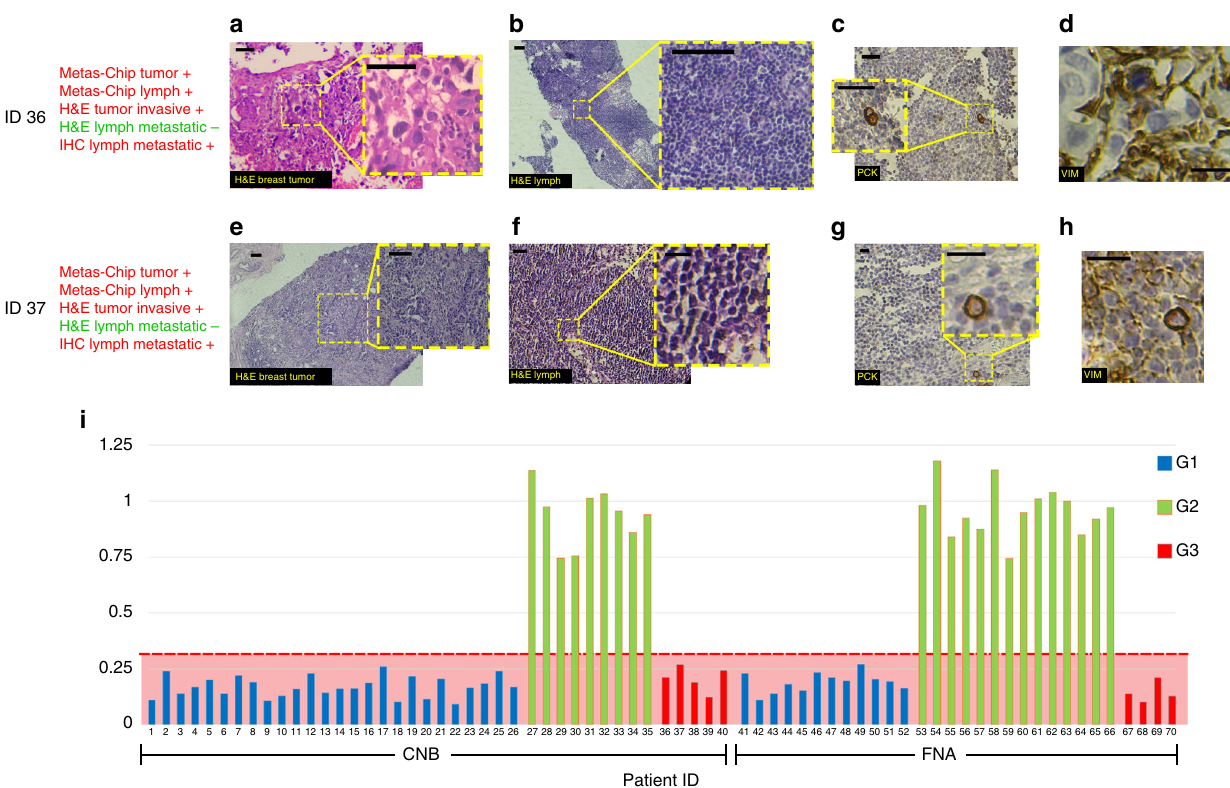
Fig. 4 H&E stained from breast specimen of patients present invasive ductal carcinoma. a , e Meanwhile H&E staining results from the lymph nodes of the patients presented no trace of tumor cells ( b , f ). Multilevel IHC staining from the lymph nodes of the patents revealed the presence of at least one tumor cell sharply expressing the PCK ( c , g ) or Vimentin ( d , h ) for both suspicious patients. i Diagnostic chart of Metas-Chip showing “ fi nal electrical response of the fourth hour after adding the lymph sample to Metas-chip/Initial electrical response before adding the sample ” for all patients. The scale bars are 25 µ m in